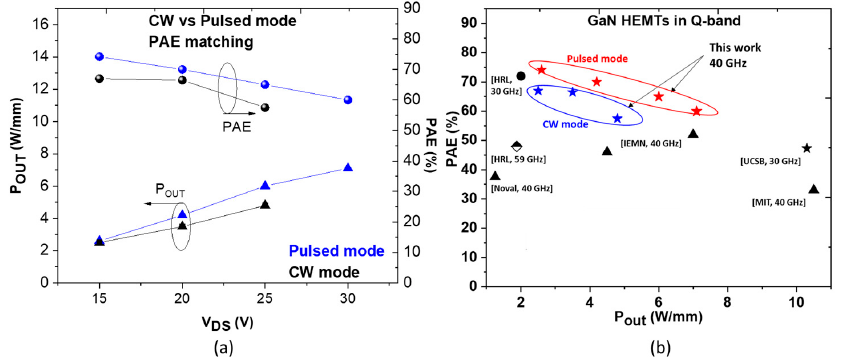
Figure 6. CW and pulsed P OUT and PAE as a function of V DS at 40 GHz for AlN/GaN HEMT (Al-25% structure) ( a ) and PAE versus P OUT benchmark of GaN HEMTs in Ka and Q-band ( b ).